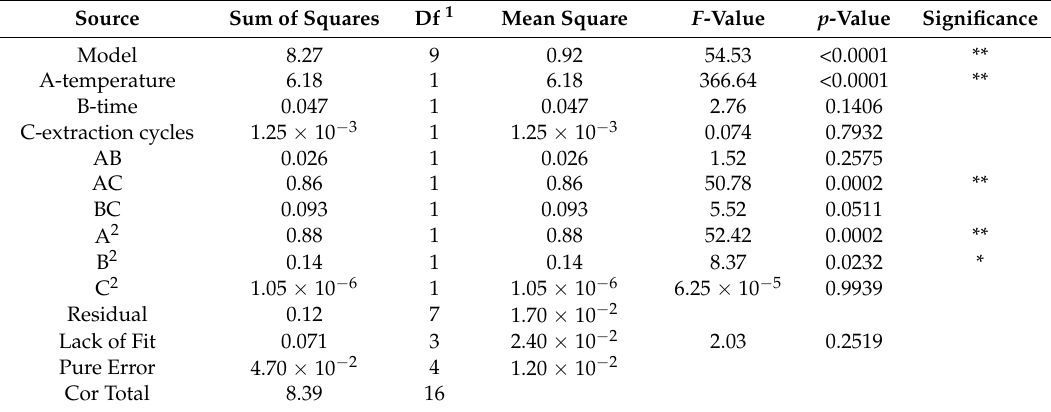
Table 2. The analysis of variance (ANOVA) for the experimental